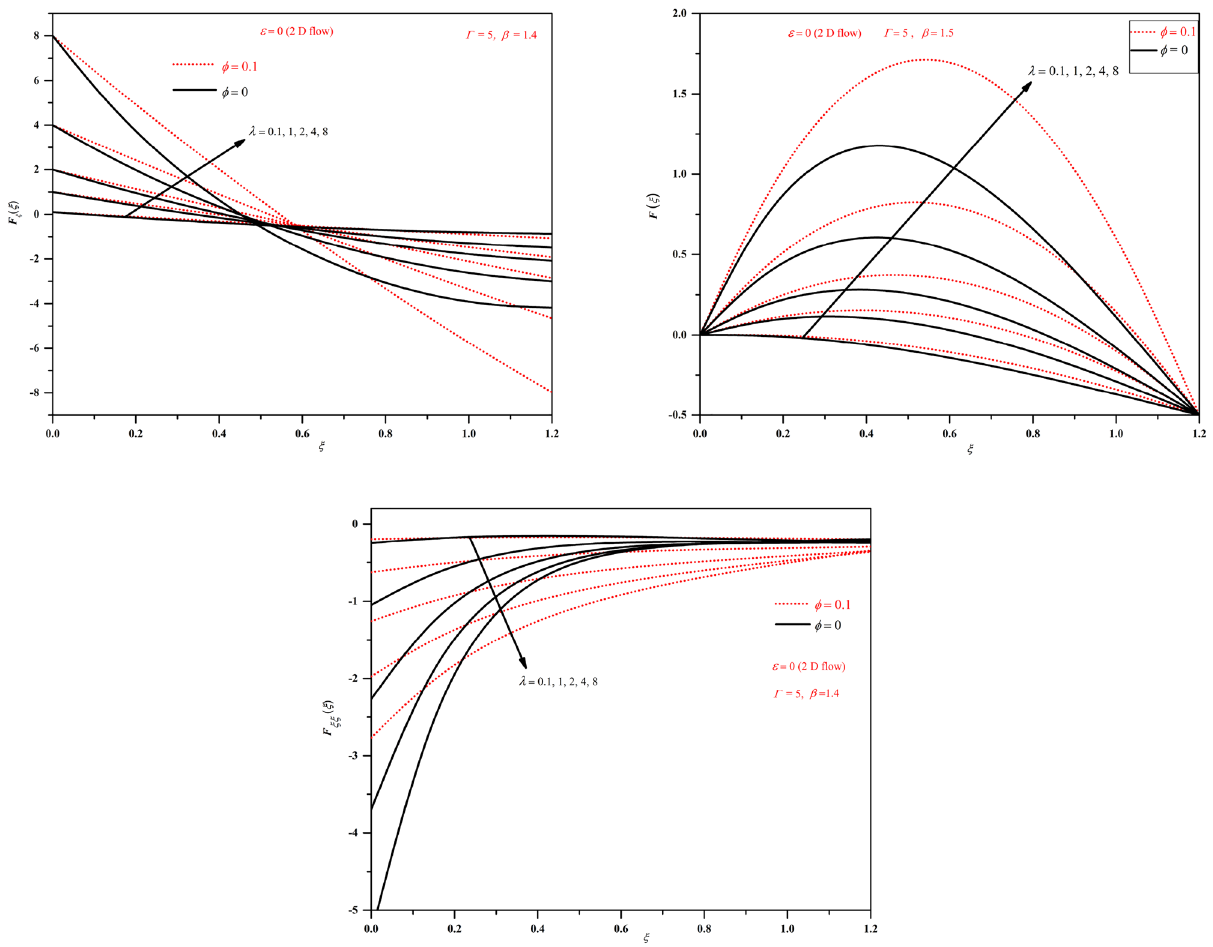
Figure 3. Plots of F , F ξ and F ξξ by varying (cid:31) (stretching wall (cid:31) > 0 ) in the two-dimensional